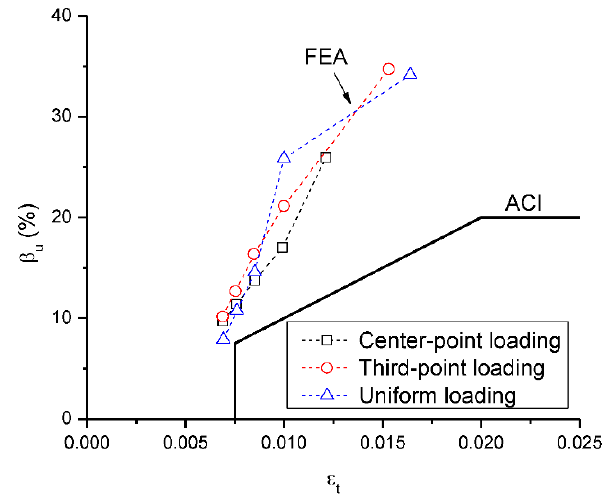
Figure 17. Relationship between β u and ε t according to FEA and ACI.